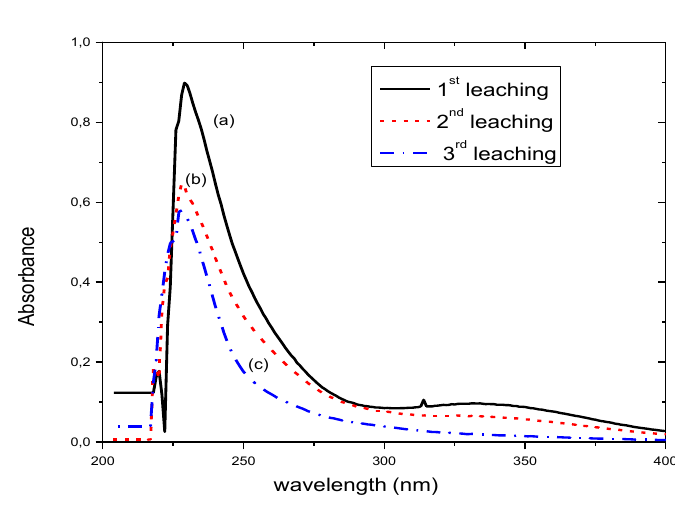
Fig. 1. UV absorption spectra of solution for different leaching